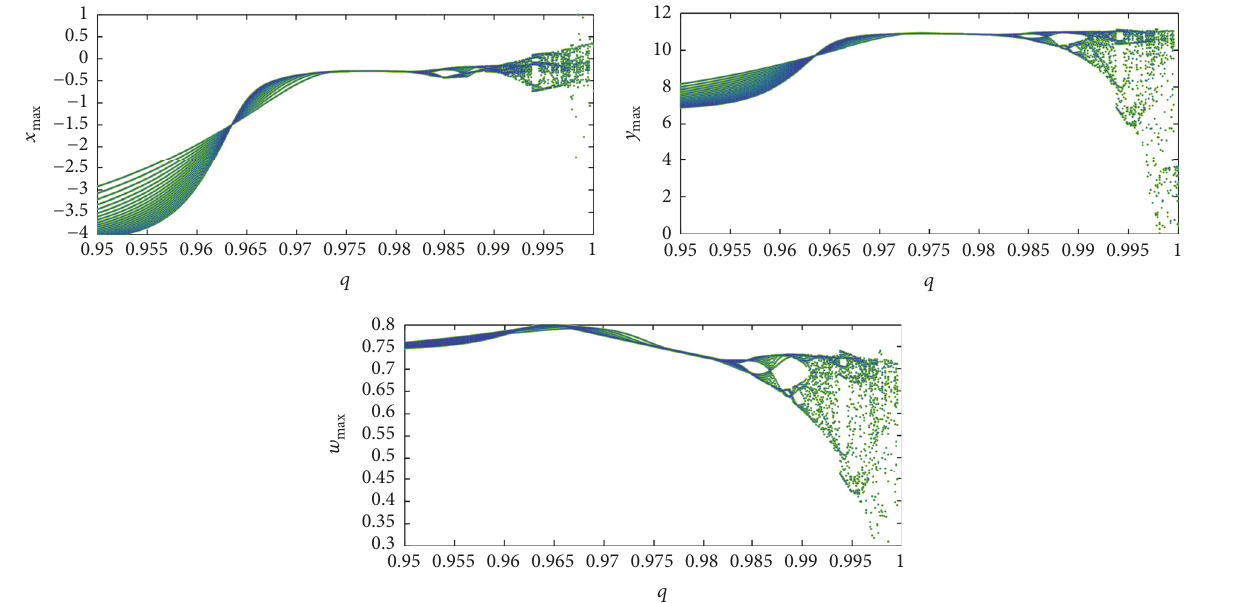
Figure 8: Bifurcation of FOPF system with fractional order 𝑞